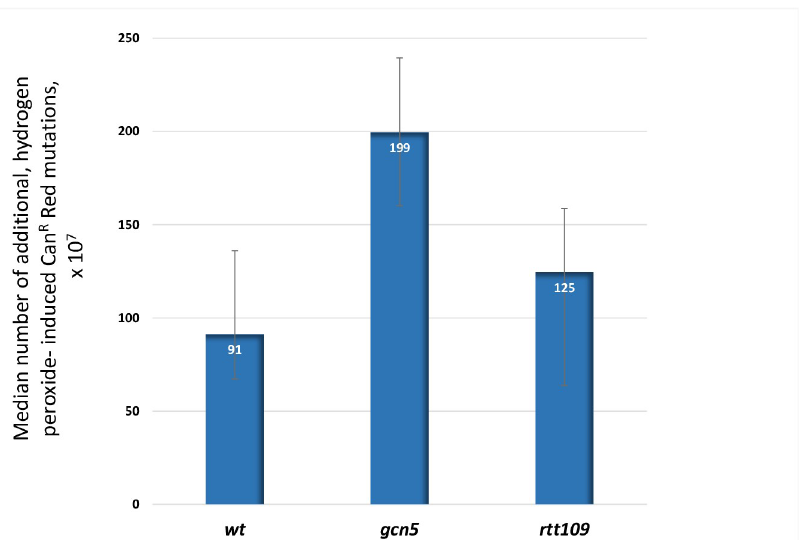
Fig 2. Exposure to hydrogen peroxide leads to significant increase in frequencies of additional (compared to spontaneous) closely spaced (CanR Red) mutations in ssDNA in the gcn5 mutant. Mutation frequency measurement experiments were set up in such a way that each individual culture had been split and either exposed or mock exposed to hydrogen peroxide (Materials and methods). The number of additional hydrogen peroxide–induced mutations in each culture can be calculated by subtraction of the frequencies of spontaneous mutations from the frequencies of induced mutations. Utilization of the number of additional peroxide-induced mutations as a parameter for comparison allows for better control of the differences in technical repeats of the experiment when the slight differences in the conditions could make the base level of the mutations differ from one repetition to another. Whiskers represent 95% confidence limits for median of mutation frequencies. The median frequency of hydrogen peroxide–induced, closely spaced CanR Red mutants is significantly increased in gcn5 compared to wild type ( P = 0.0014 by Mann–Whitney test). See also S1 Data. CanR Red, canavanine-resistant red; ssDNA, single-strand